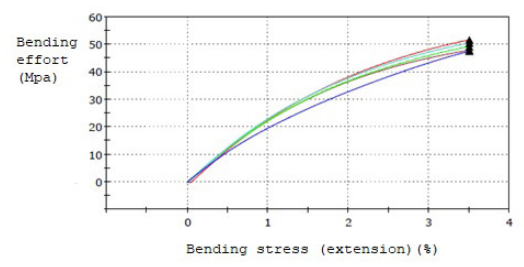
Figure 6. Tensile test for virgin PP.